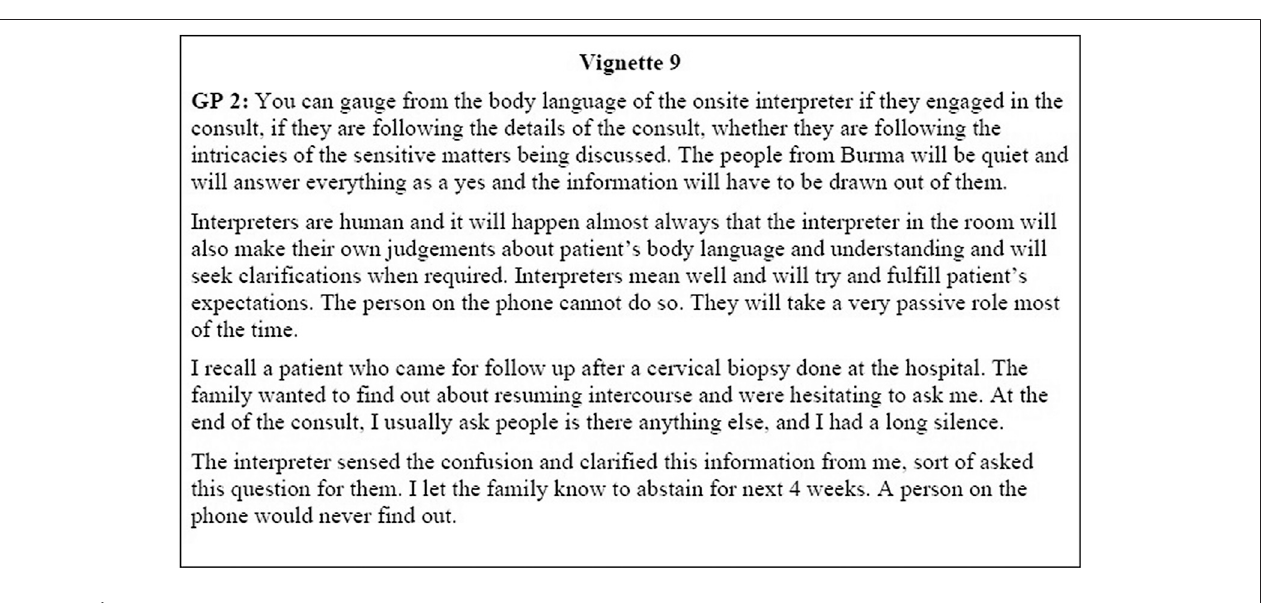
FIGURE 9 | On-site interpreters to telephone